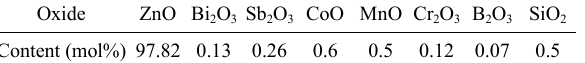
varistor slurry